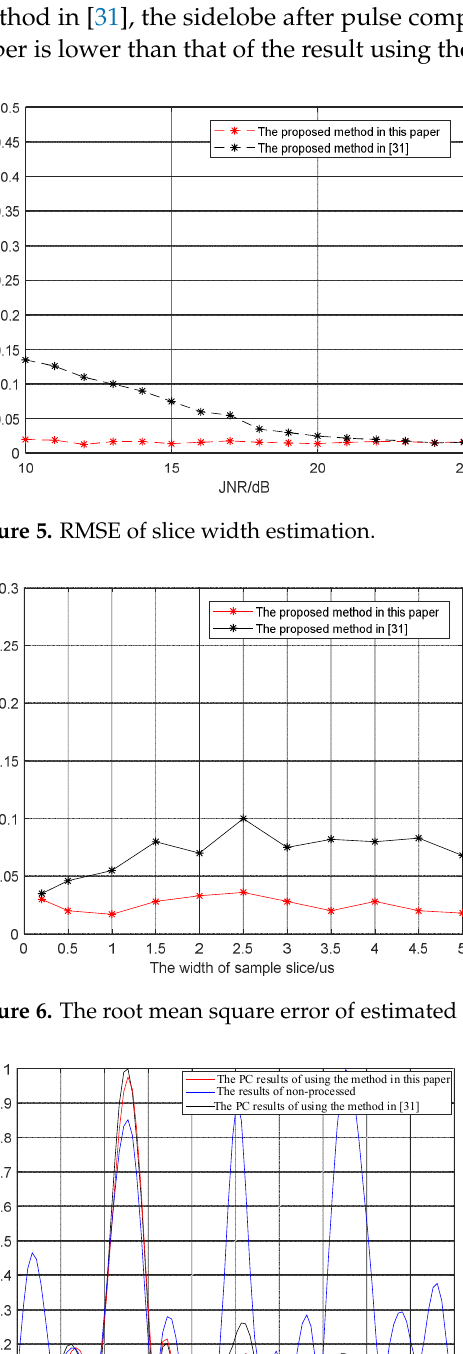
Figure 7. ISRJ suppressed results.